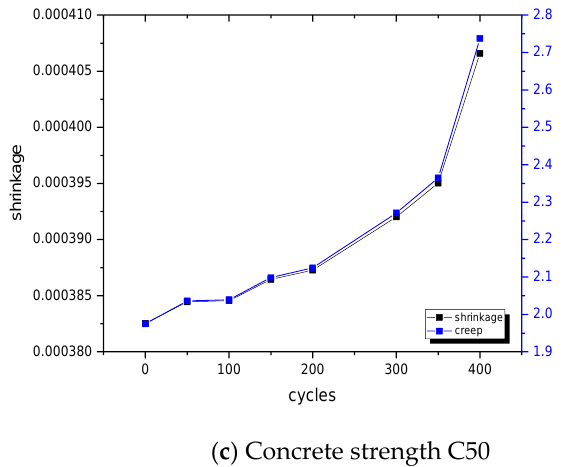
Figure 8. Effect of freeze–thaw on the time-dependent behaviour of prestressed concrete sleepers.